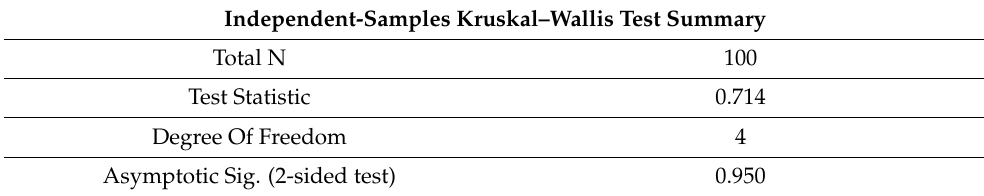
Table 4. Results of Kruskal–Wallis one-way ANOVA on ranks test for average return by